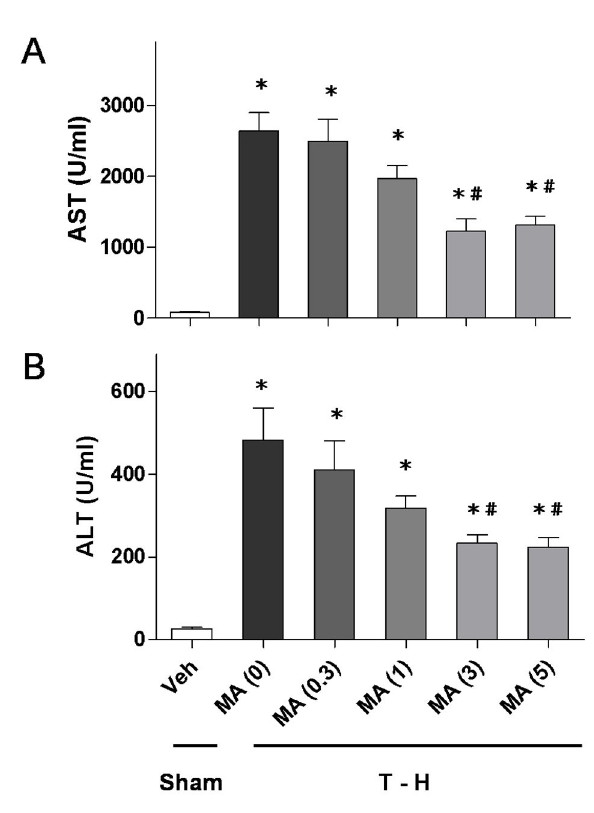
Figure 1. Dose-dependent responses to maraviroc treatment of plasma AST (A) and ALT (B) in rats at 24 hours after sham operation (sham) or trauma-hemorrhage and resuscitation (T-H). Animals were treated with maraviroc (MA) at doses of 0, 0.3, 1, 3, or 5 mg/kg. Data are shown as the mean ± SEM. n=6 rats in each group. * p <0.05 compared with sham; # p <0.05 compared with T-H + MA (0 mg/kg). doi: